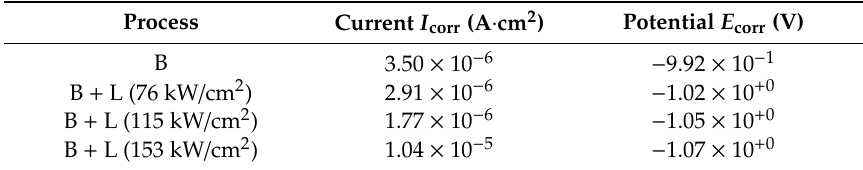
Figure 6. Potentiodynamic curves obtained during corrosion resistance tests of the layer. Table 5. Corrosion resistance parameters for diffusion boronizing layers (B) and a boronized layer after laser processing (B + L).